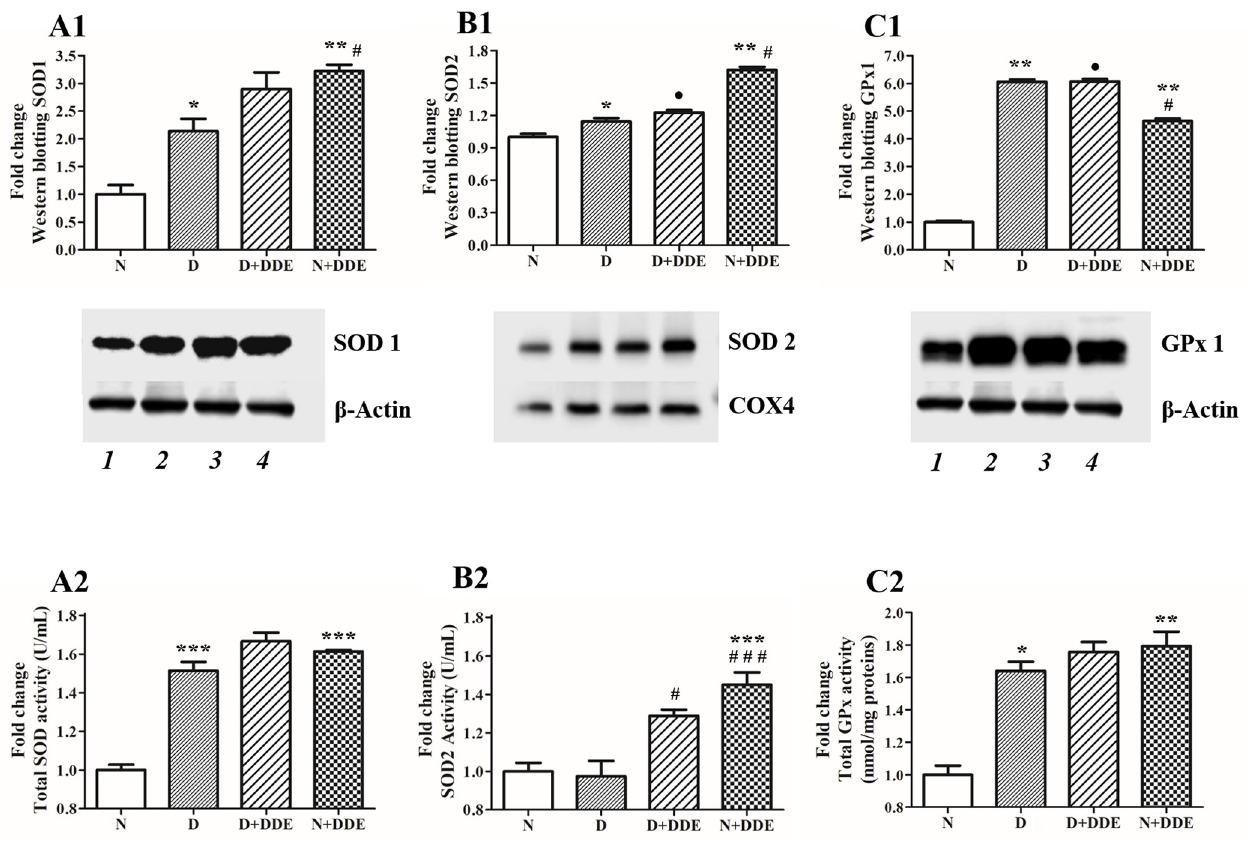
Fig 6. Western blotting and enzymatic activity of antioxidant enzymes. (A1) Hepatic cytosolic SOD1 content; (A2) Total SOD activity; (B1) Hepatic mitochondrial SOD2 content; (B2) SOD2 activity; (C1) Hepatic GPx1 content; (C2) Total GPx Activity. WB intensity of the bands were normalized to that of β -actin (in A1 and C1) or COX4 (in B1). Lines legend: 1, N; 2, D; 3, D+DDE; 4, N+DDE. Significance of differences is shown. � p < 0 . 05 vs. N; �� p < 0 . 01 vs. N; ��� p < 0 . 001 vs. N; # p < 0 . 05 vs. D; ## p < 0 . 01 vs. D; ### p < 0 . 001 vs. D; • p < 0 . 05 vs. N+DDE.